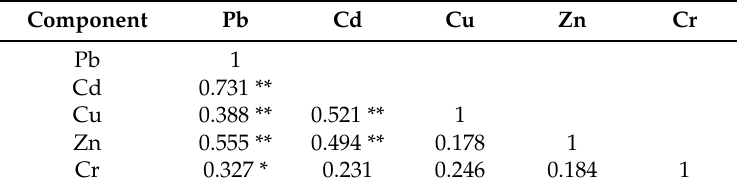
Table 13. Correlation coefficients between different metals ( n =